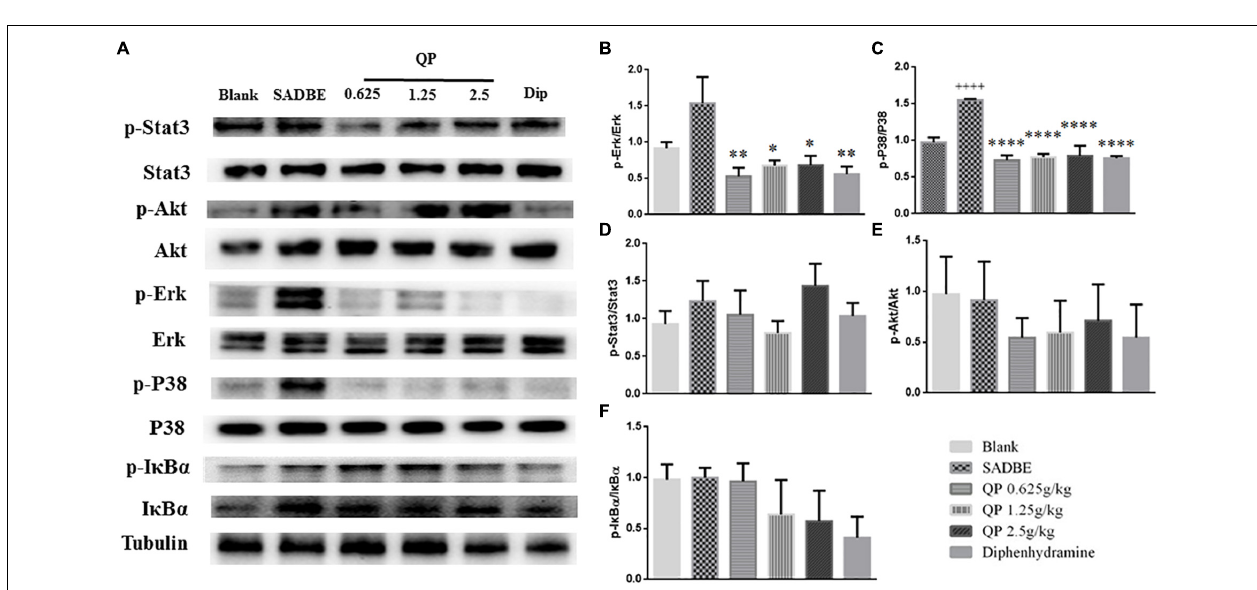
FIGURE 5 | The mRNA of IL-5 (A) , IL-10 (B) , TRPV4 (C) , TSLP (D) , GRP (E) , and MrgprA3 (F) were detected in mouse skin. After mice were treated with different doses of QP ointment and diphenhydramine, the targeted molecular mRNA levels were measured as well as that in the model group or the blank control group. Data was expressed as mean ± SEM. ∗ p < 0.05, ∗∗ p < 0.01, and ∗∗∗∗ p < 0.0001, compared with the model group. + p < 0.05, ++ p < 0.01, and ++++ p < 0.0001, compared with the blank control group. One-way ANOVA ( n = 5 each group).